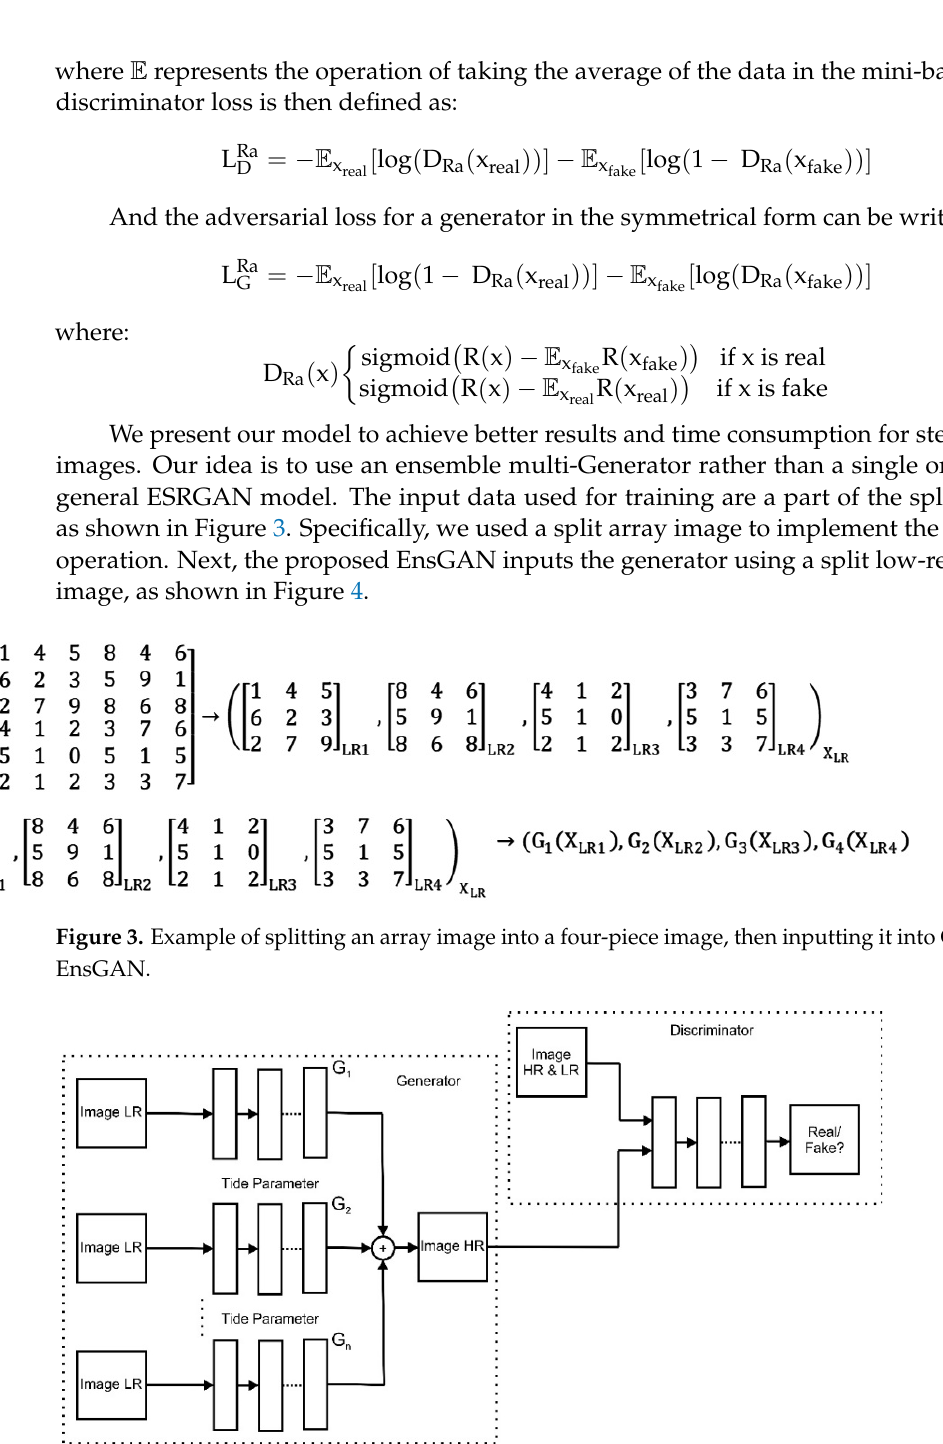
Figure 4. Proposed EnsGAN model with n generators and a discriminator. As illustrated in Figure 3, splitting an array image or Image LR from one single image and inputting it into a multi-Generator (cid:4666) G (cid:2869) ,G (cid:2870) ,…,G (cid:2924) (cid:4667) then uses the ensemble technique to reconstruct the output Image HR.